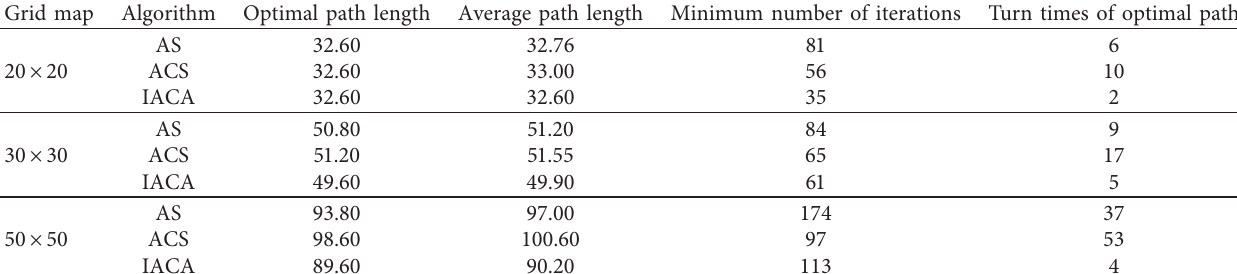
Table 1: Comparison of the results of the three algorithms in path planning.